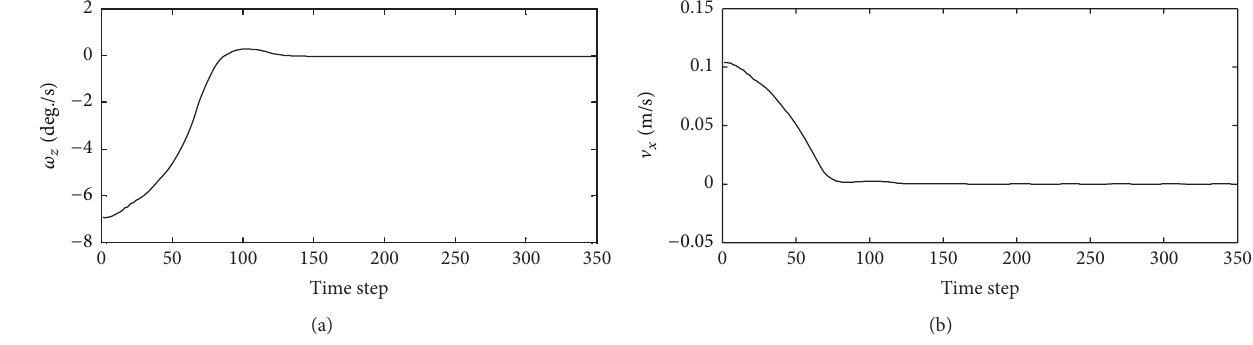
Figure 7: Control input.